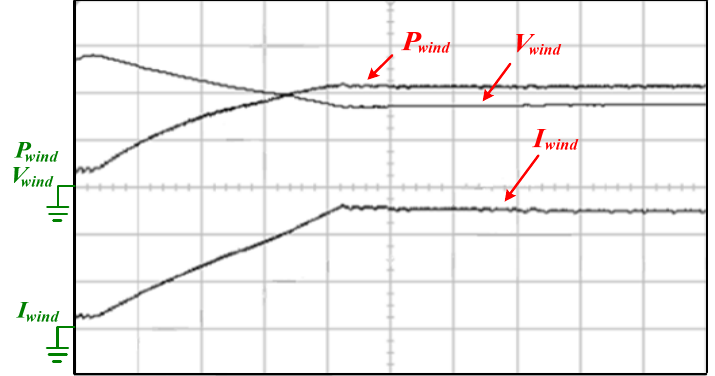
Figure 17. Measured output voltage, current and power waveforms of wind turbine with